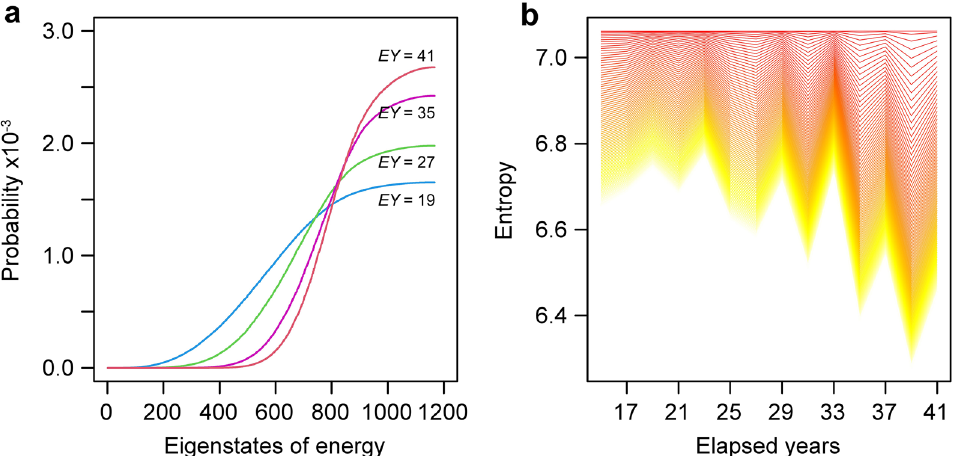
Fig. 4 a Probability distributions corresponding to each energy eigenstate at representative elapsed years. b Changes of entropy with the elapsed years for various inverse temperature conditions. The colors of the lines change from red to yellow as the inverse temperature